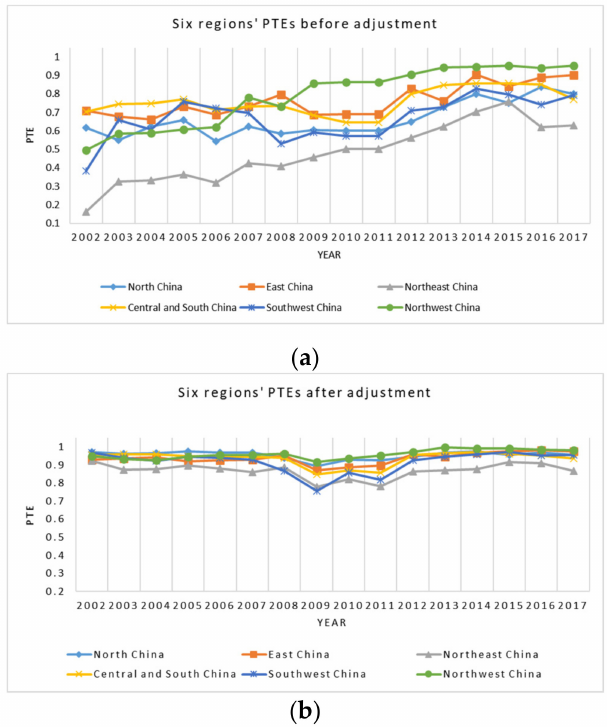
Figure 3. Six regions’ PTEs over the study period before and after the